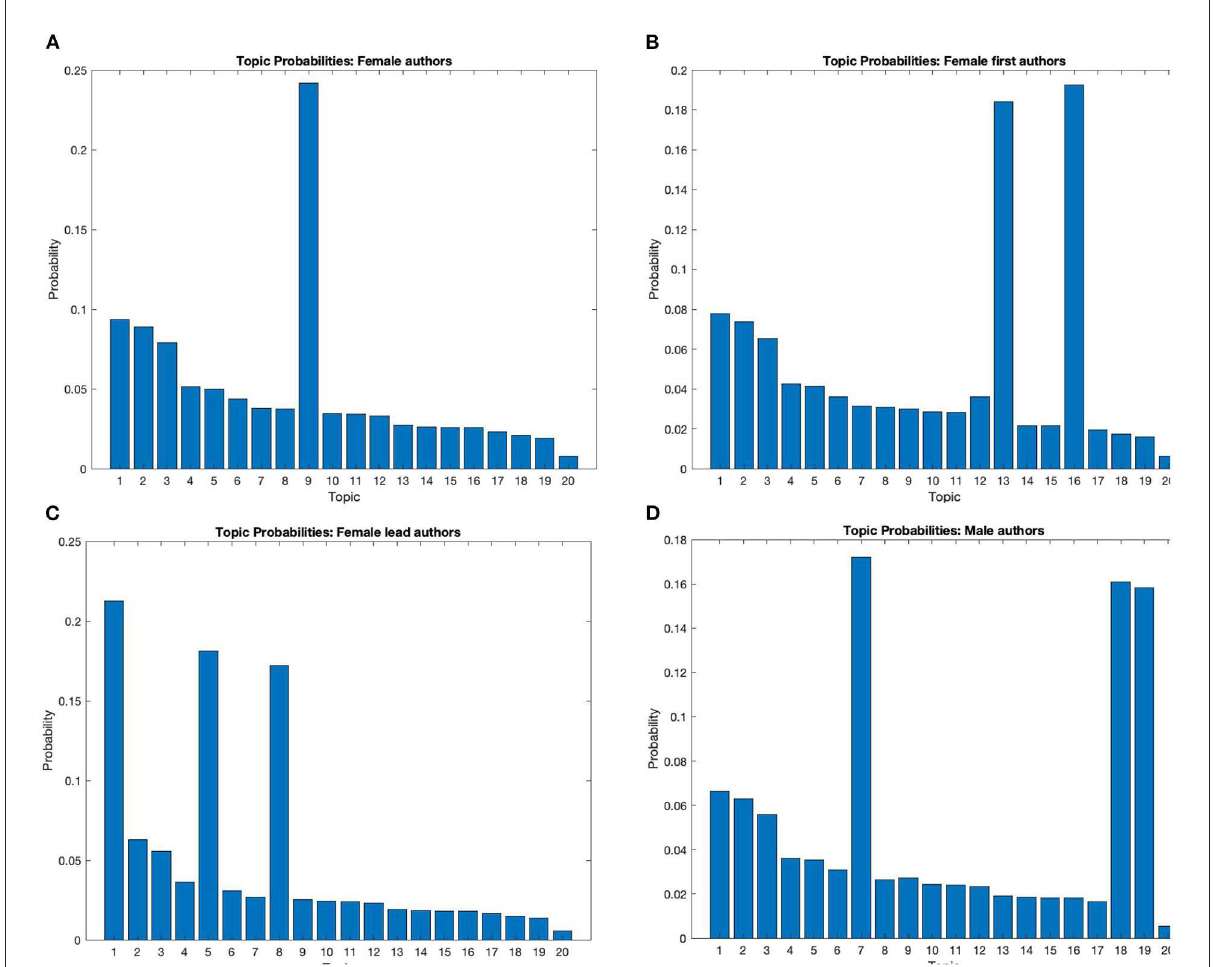
FIGURE5 Probability distribution of (A) all female authors, (B) first female authors, (C) lead female authors, and (D) male authors among the 20 topics. Each topic is represented as a number in the horizontal axis; see Figure 4 for the topic